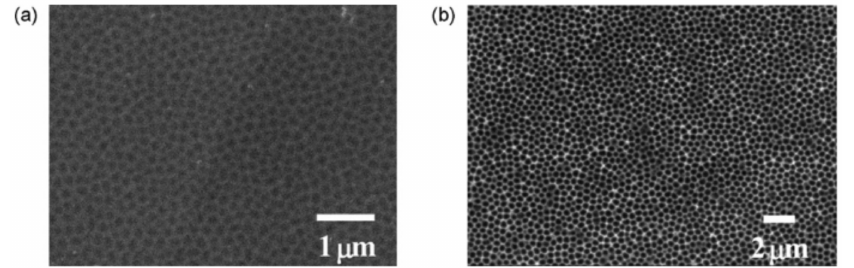
Figure 1. SEM images of nanoporous 316SS surfaces formed at 60 V in perchloric acid containing organic solvents: ( a ) ethanol, ( b ) acetic acid. Reprinted from Ref. [27] with permission from